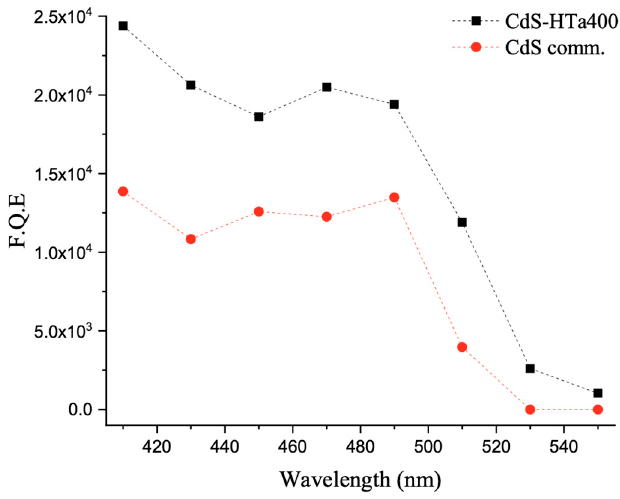
Figure 8. Formal Quantum Efficiency (FQE) for the photocatalytic hydrogenation of MO, using suspended CdS as a photocatalyst, as a function of the wavelength of incident light.